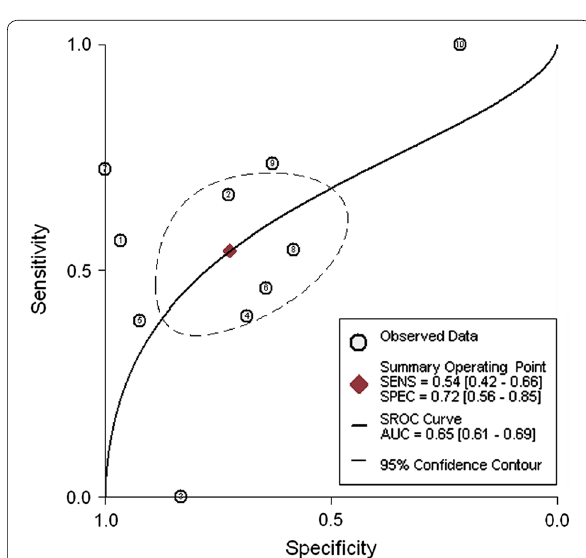
Fig. 7 Summary receiver operating curve of APT in comparison to SPT for the diagnosis of patients with atopy dermatitis. AUC, area under curve; SROC, summary receiver operating curve; SENS, sensitiv- ity; SPEC, specificity. ① Heinemann et al.; ② Wistokat-Wülfing et al.; ③ Lorenzini et al.; ④ Darsow et al.; ⑤ Kutlu et al.; ⑥ Manzini et al.; ⑦ Wananukul et al.; ⑧ Michel et al.; ⑨ Holm et al.; ⑩ Fuiano et